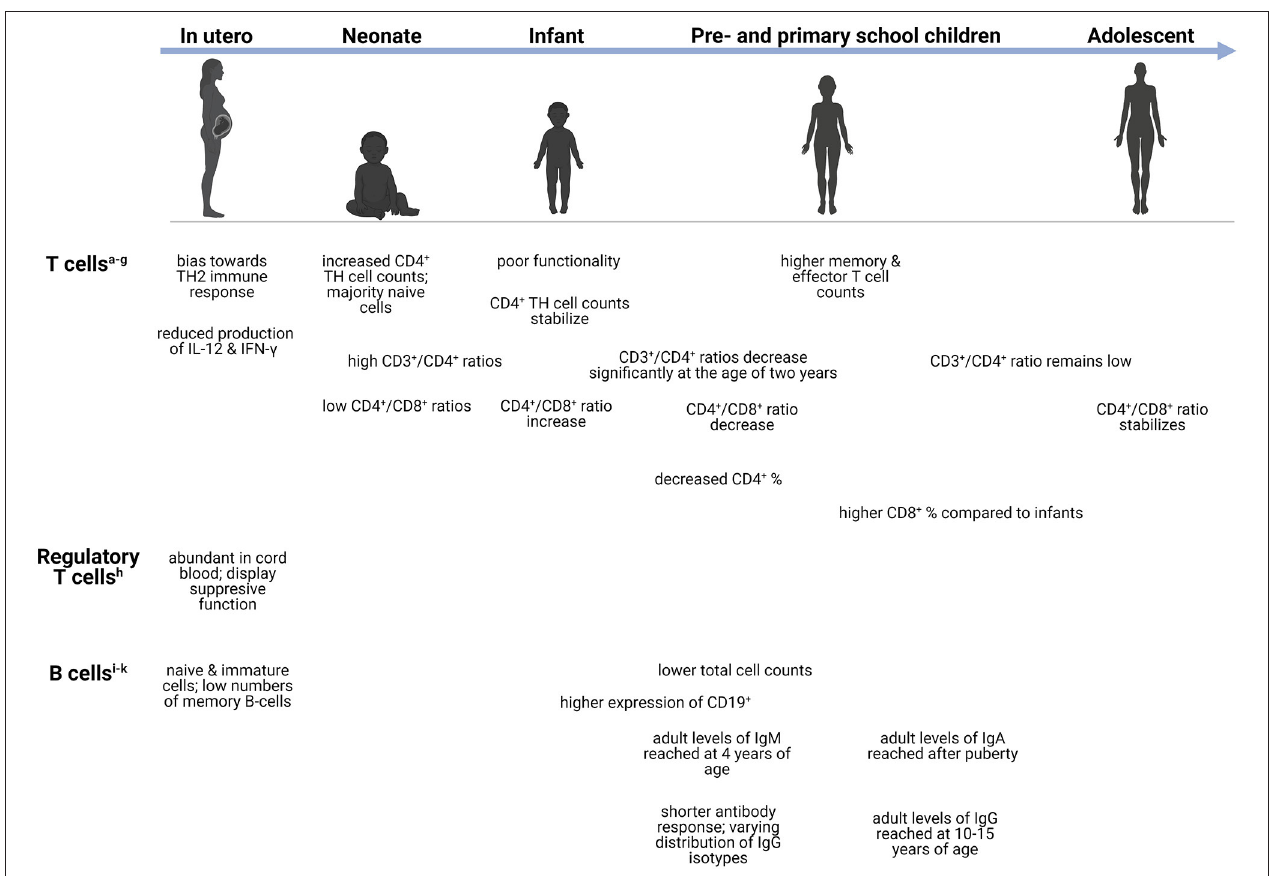
FIGURE 2 | Age-dependent differences in the adaptive immune system. Changes in the adaptive immune cells during development, from neonate (infants in the first 28 days after birth), infants (0–1 years), preschool children (1–6 years), primary school children (6–12 years), to adolescents (12–18 years). a CD4 + T cells-helper cells that produce variety of cytokines (23). b TH1 cells-produces IFN- γ and initiates protective immune responses against viral/bacterial infections (24). c TH2 cells-produces IL-4, IL-5, IL-9, IL-13, and IL-15 ( 24). d TH9 cells-produces IL-9, IL-10, and IL-21 (25). e TH17 cells-respond to extracellular bacteria and fungi (24). f CD3 + T cells-important for activation of CD4 + and CD8 + T cells (26). g CD8 + T cells-cytotoxic cells capable of TNF- α and IFN- γ mediated killing (27). h Treg cells-immunosuppression of CD4 + and CD8 + cell function; release inhibitory cytokines (24). i Memory B cells-exerts immunosuppression; can rapidly differentiate into effector cells following antigen recognition (28). j Transitional B cells-exerts immunosuppression through IL-10 production (29). k Plasma blasts-most mature class-switched subset of memory B cells (30). CD, cluster of differentiation; Ig, immunoglobulin; IL, interleukin; IFN- γ , interferon- γ ; TH, T-helper; TNF- α , Tumor necrosis factor- α